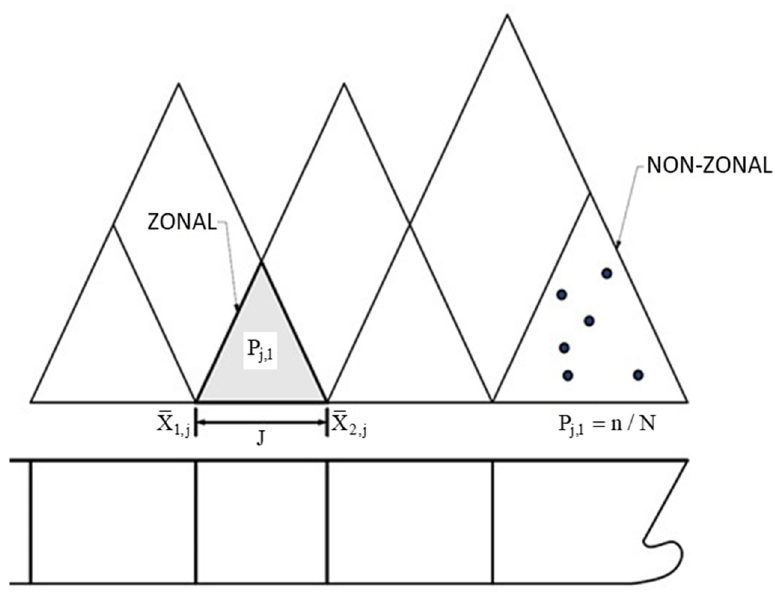
Figure 7. Zonal vs non-zonal 1-compartment damage.